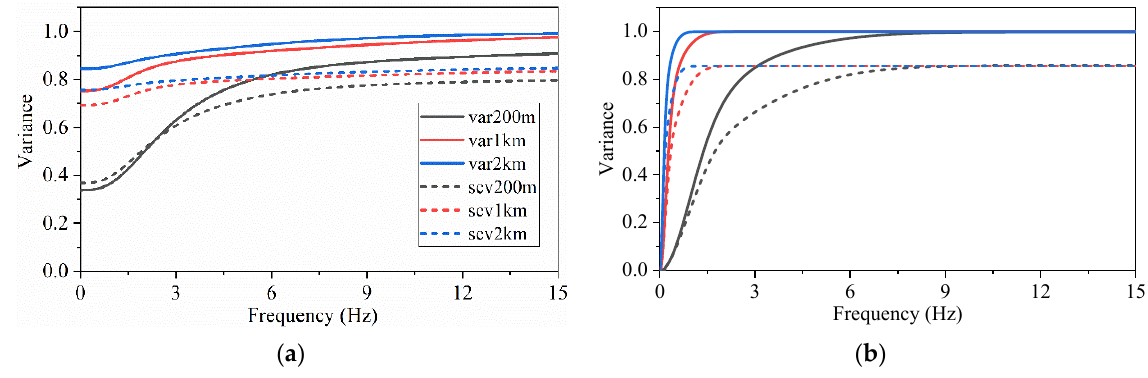
Figure 5. Loop variance vs. loop SCV: ( a ) HV1 model and ( b ) LW model. An adjustment coefficient, denoted by I cv , is introduced to restore the loop SCV to the loop variance.